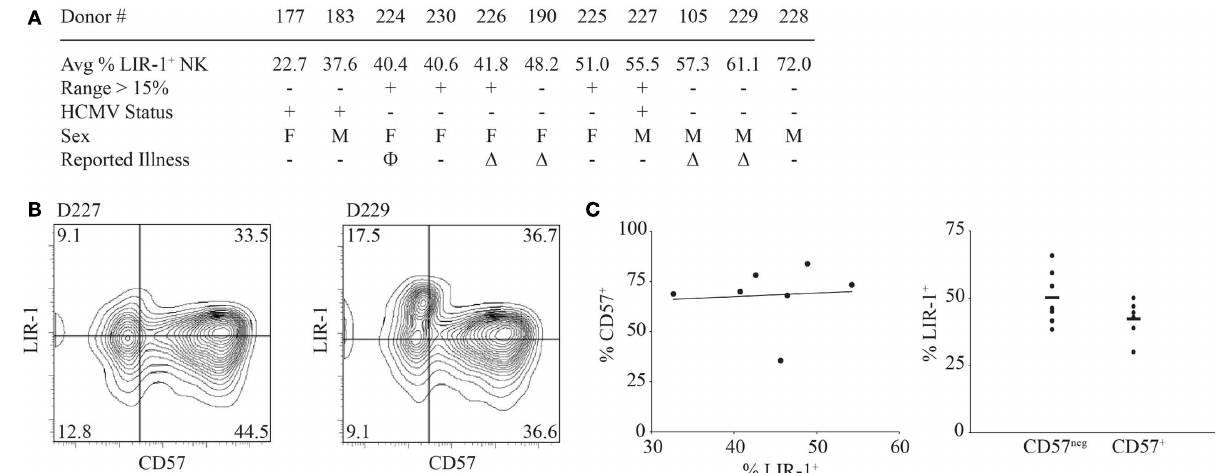
FIGURE 3 | Natural killer cell LIR-1 expression, demographics, and maturation. (A) The sex and HCMV status is shown relative to the average percent of LIR-1 + NK cells for the same set of donors in Figure 2 .The HCMV status was determined at the end of the study.The “ + ” indicates positive serology for HCMV (see Materials and Methods for details). All donors fall within the age range of 20–40years old. For reported illnesses Δ represents common cold symptoms reported and Φ represents reported allergy symptoms at the time of a donation. (B) High LIR-1 expression does not